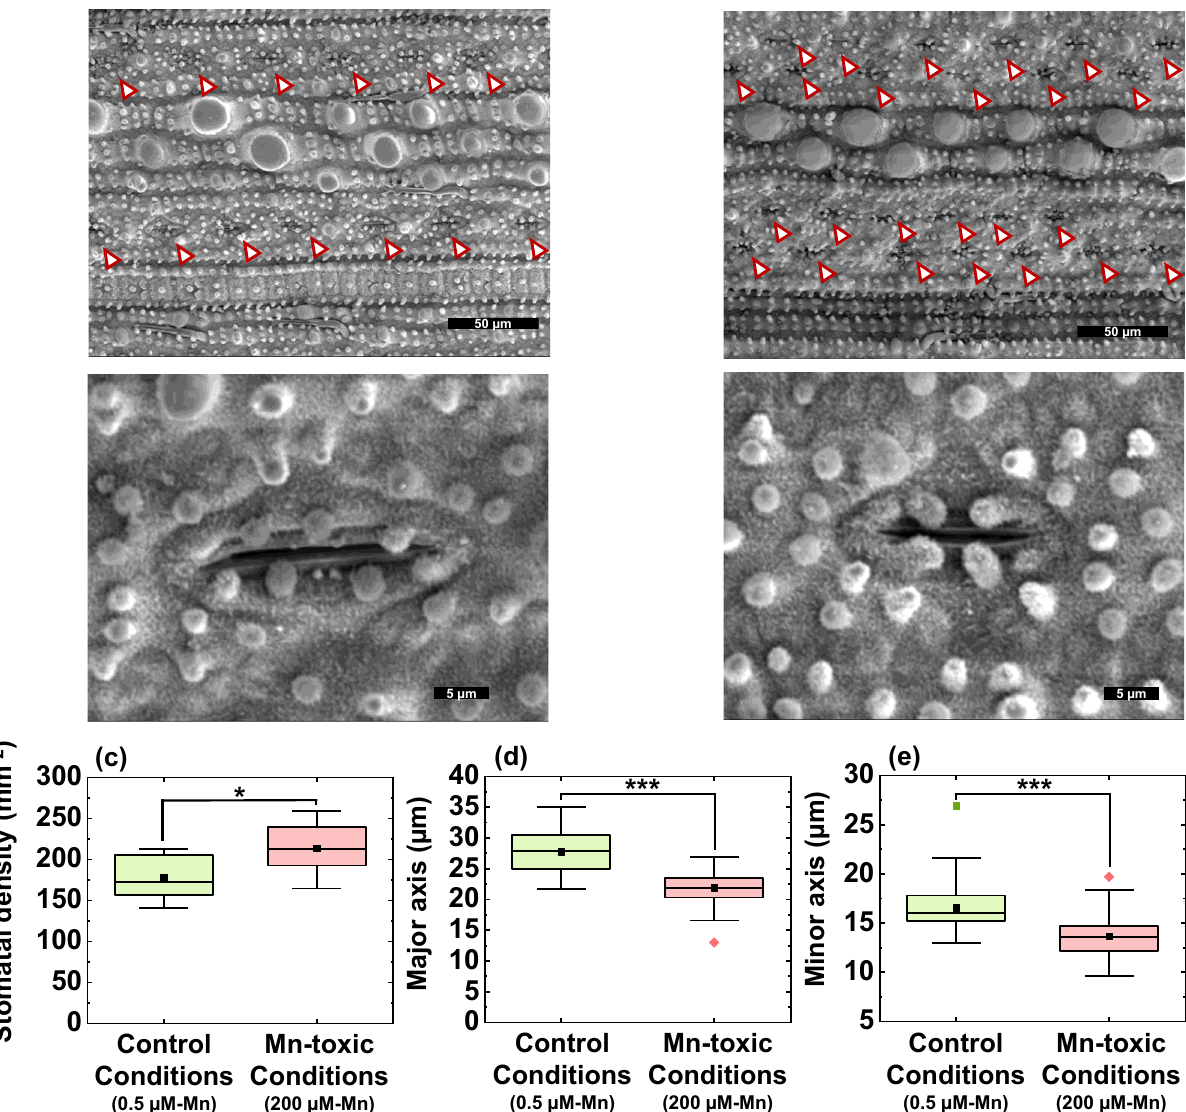
Figure 6. Stomatal structures and characteristics in the rice leaf blade. Pictures of the stomata on the abaxial side of the leaf blade grown under control ( a ) and Mn-toxic ( b ) conditions. The upper pictures focus on the stomatal distributions, and the lower pictures focus on the single stomata complex. ( c ) stomatal density (n = 10–12). ( d , e ) Show the major and the minor axis of the stomatal complex, respectively (n = 53–63). Data are shown as box plots, black squares indicate the mean value, and bars indicate the range of the maximum or minimum data within a 1.5 × interquartile range (IQR), and these data were obtained from the six independent biological replicates and independent technical replicates as indicated. The green boxes indicate the results under control conditions, and the red boxes indicate those under Mn-toxic conditions. Asterisks represent significant differences between the control and Mn-toxic conditions (* p < 0.05, *** p < 0.001, Kruskal–Wallis